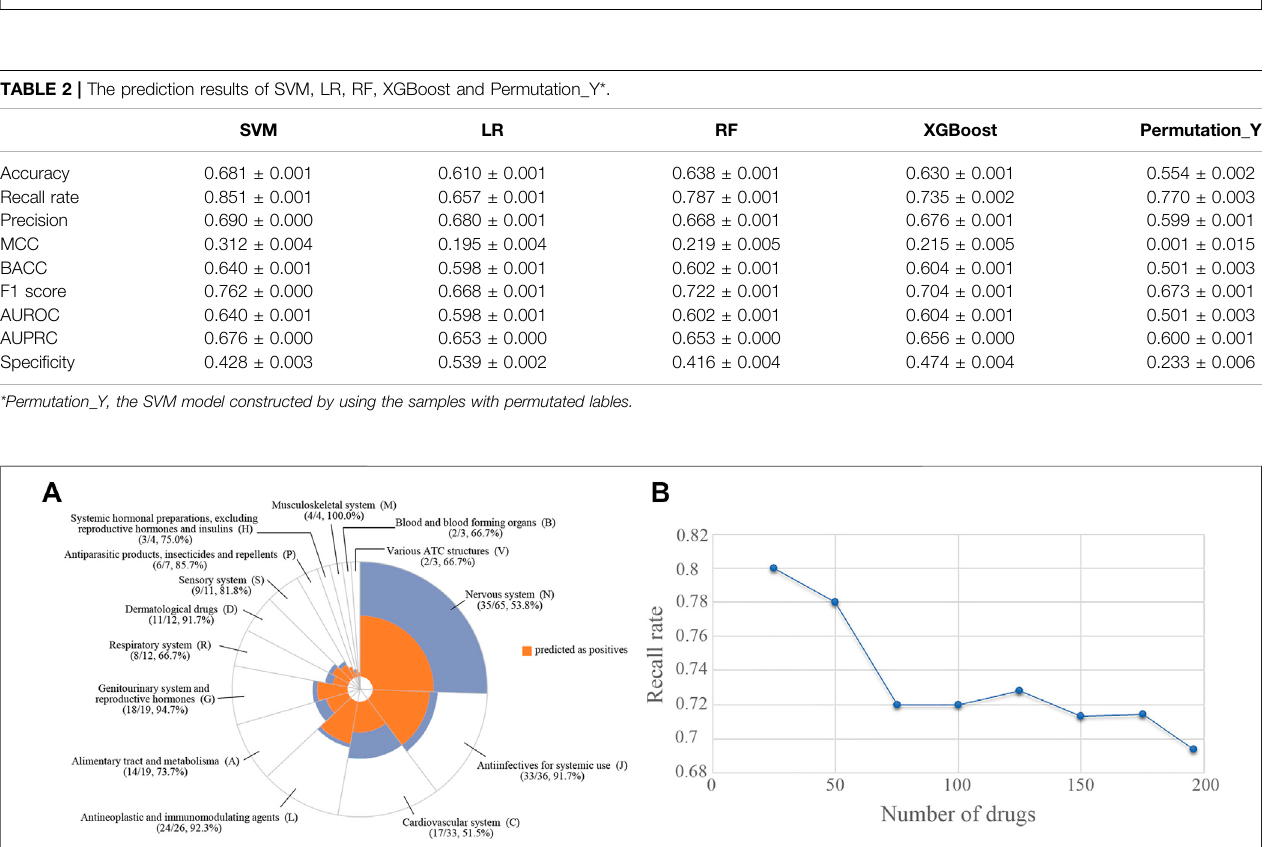
Frontiers in Pharmacology |